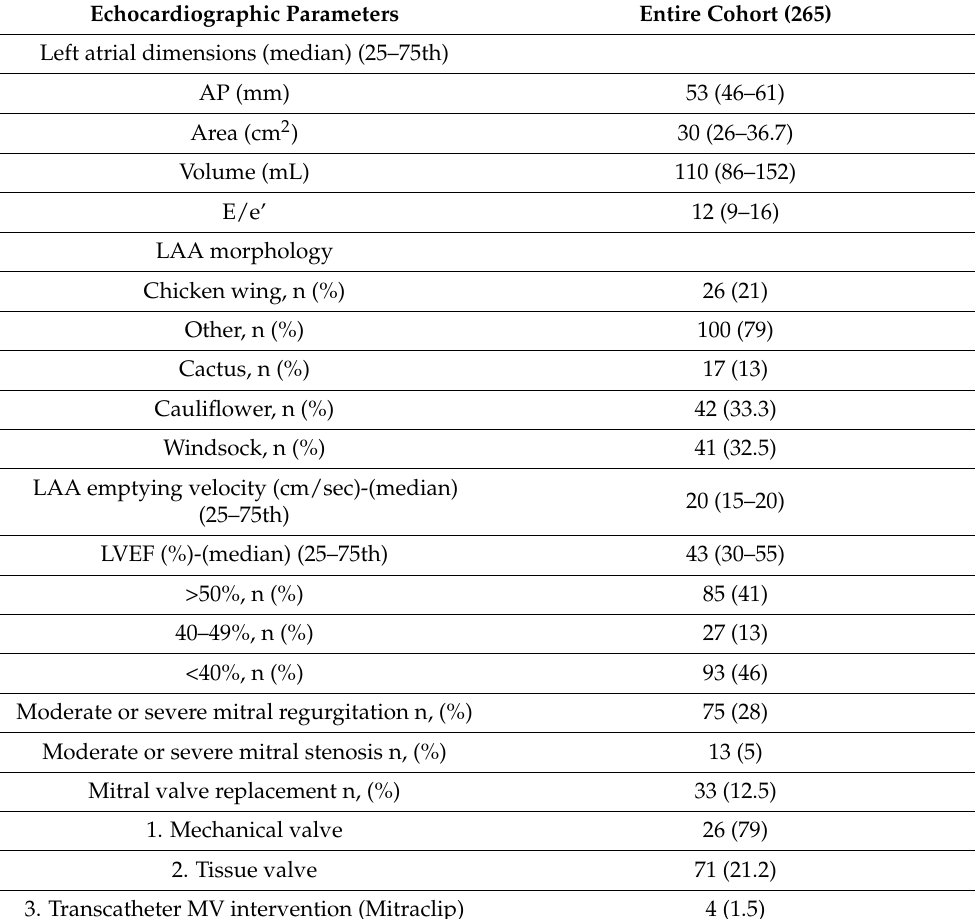
Table 2. Echocardiographic characteristics at first TEE. AP, anterior-posterior; LAA, left atrial ap- pendage; MV, mitral valve.